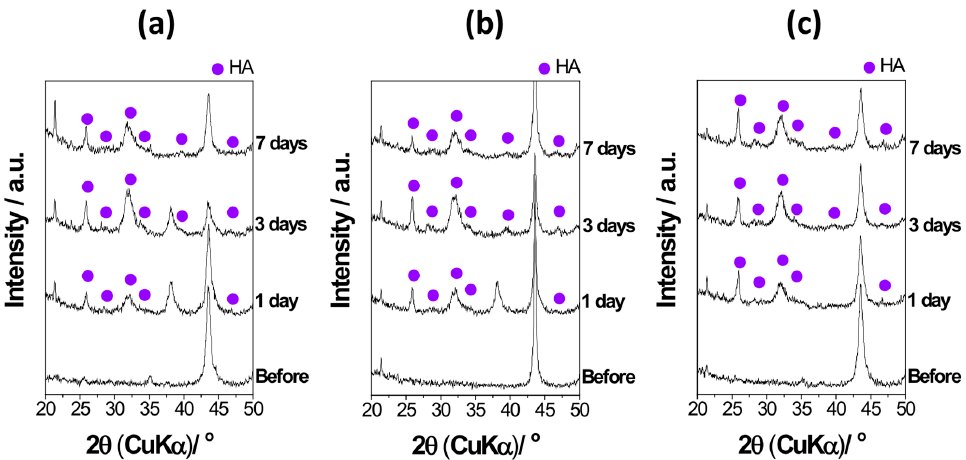
Figure 8. XRD patterns of ( a ) S14, ( b ) S3 and ( c ) S14-3 after ‘Basic SBF’ treatment (Before) and subsequently soaking in SBF for 1 day, 3 days and 7 days.